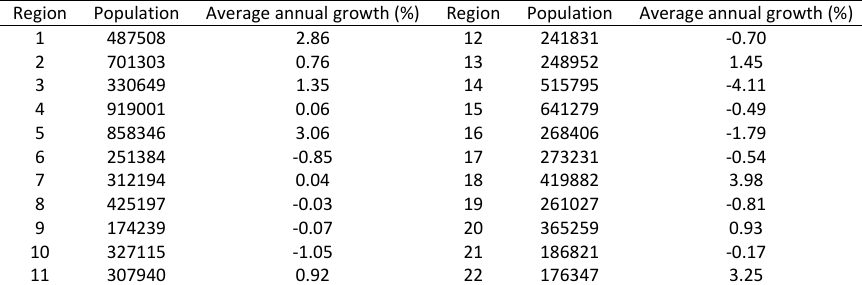
Table 1: Population and population growth rate of Tehran in 2016 (TM, 2018) Table 1. Population and population growth rate of Tehran in 2016 (TM, 2018)